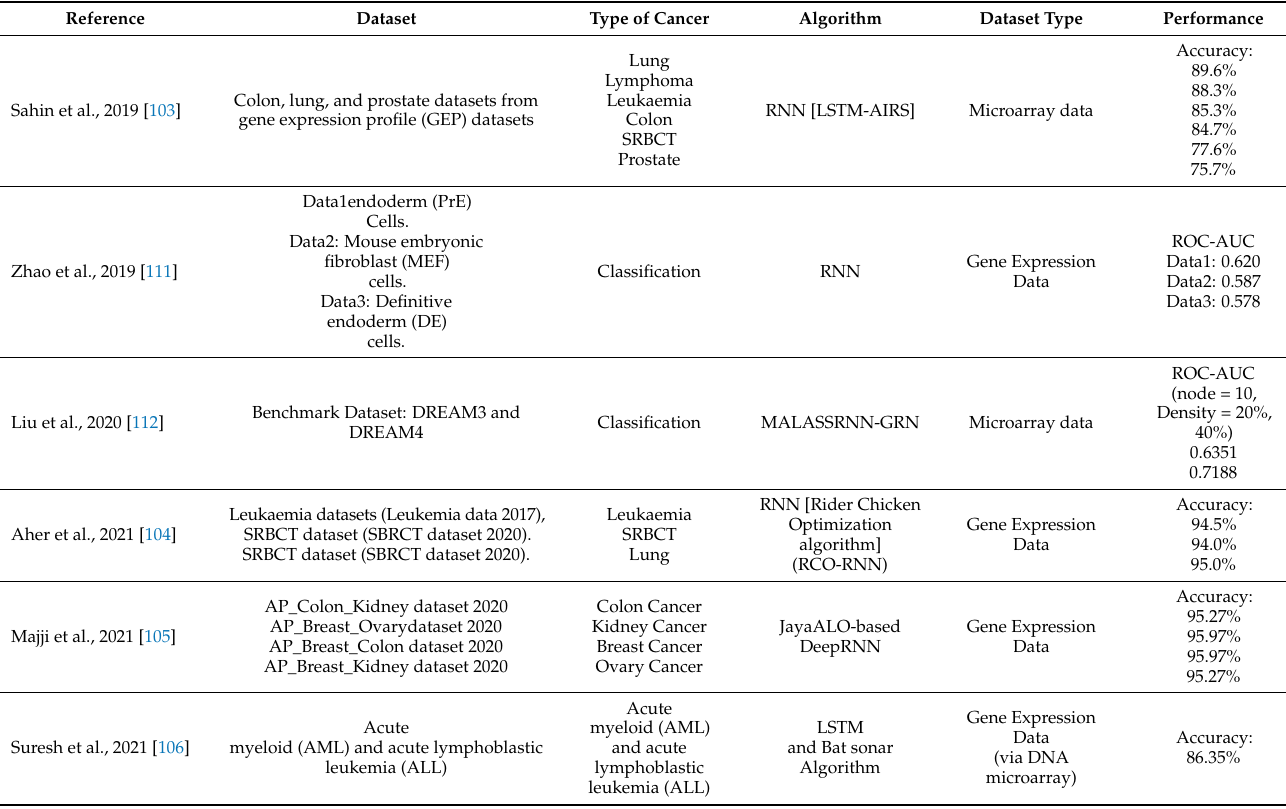
Table 8. Deep learning-based RNN methods for gene expression